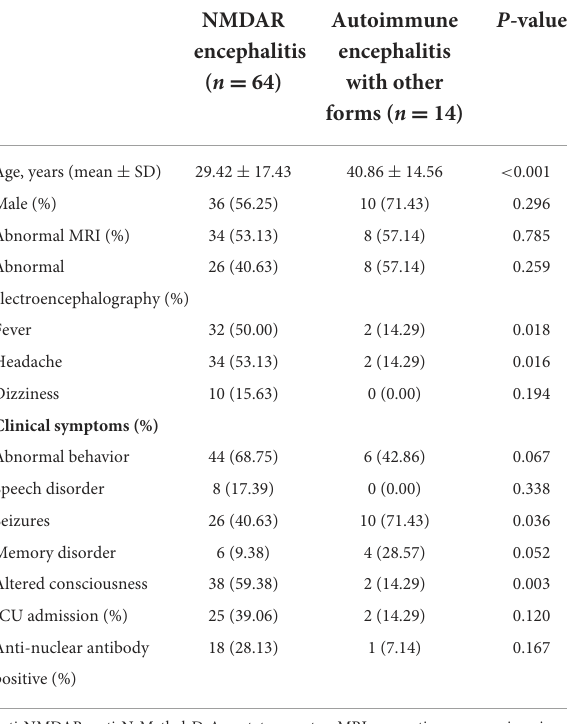
TABLE 1 The clinical characteristic between anti-NMDAR encephalitis and autoimmune encephalitis with other forms.